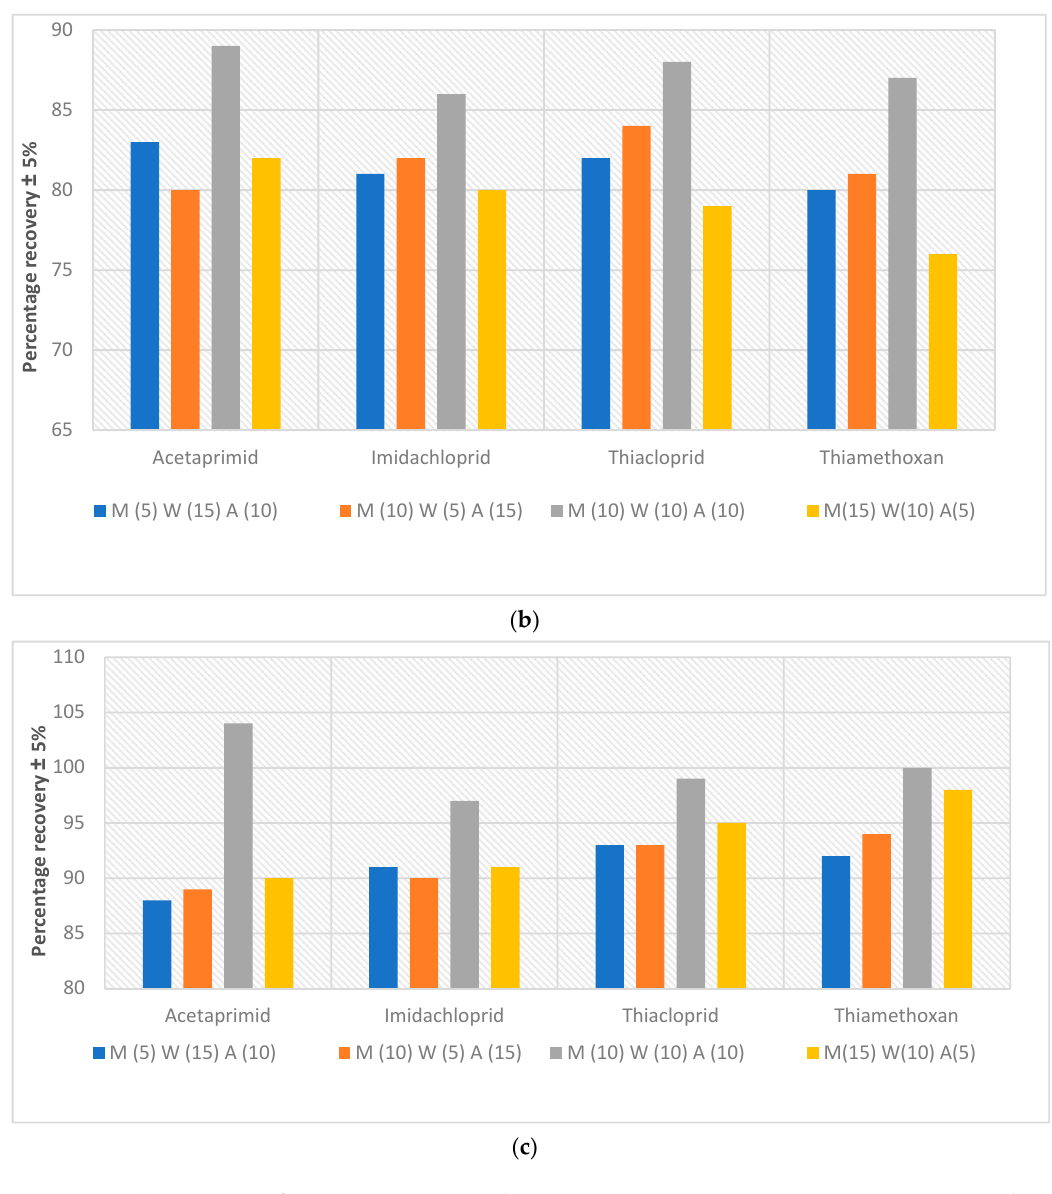
Figure 4. ( a ) Recovery of neonics at 1 ppm spikes. M = CH 3 OH, W = D.I. water, A = Acetonitrile. The bracketed numbers are liquid volumes in mL (cm 3 ). ( b ) Recovery of neonics at 0.5 ppm spikes. M = CH 3 OH, W = D.I. water, A = Acetonitrile. The bracketed numbers are liquid volumes in mL (cm 3 ). ( c ) Recovery of neonics at 0.1 ppm spikes. M = CH 3 OH, W = D.I. water, A = Acetonitrile. The bracketed numbers are liquid volumes in ml (cm 3 ).